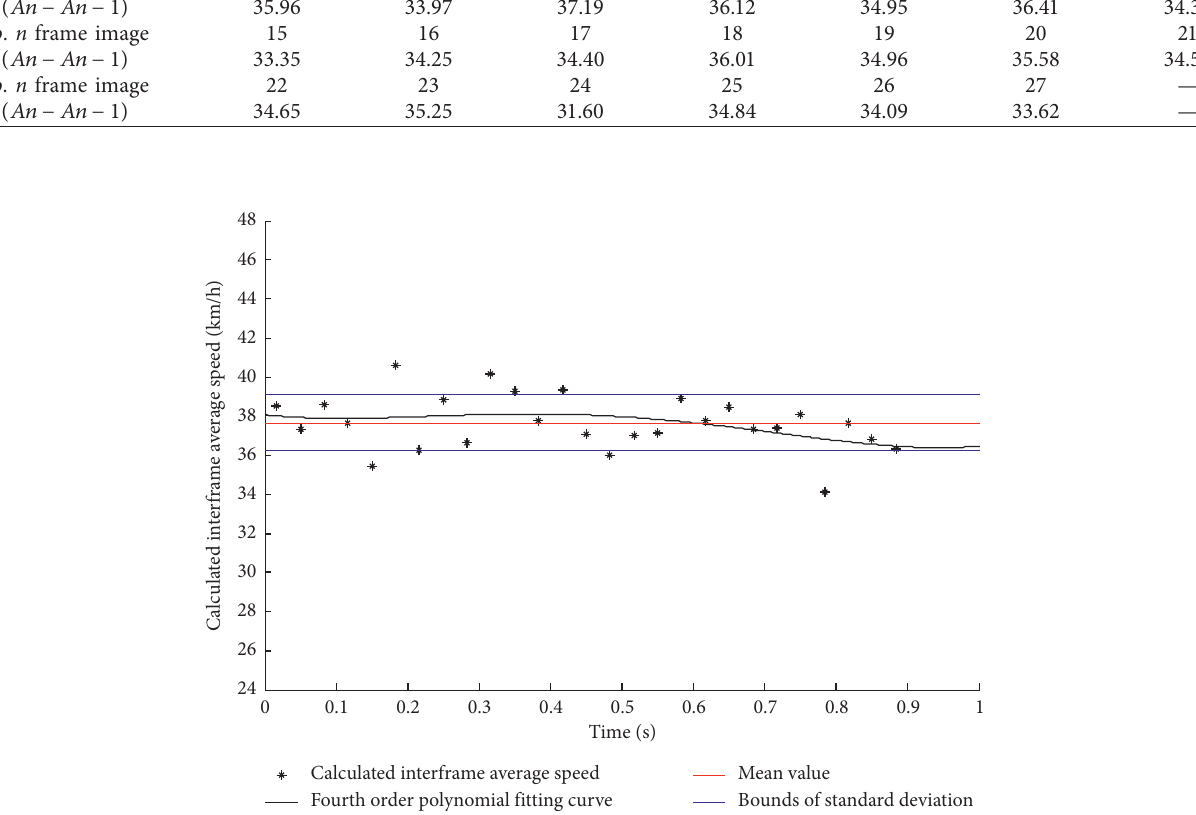
Figure 7: Calculated average speed and its fitting curve.